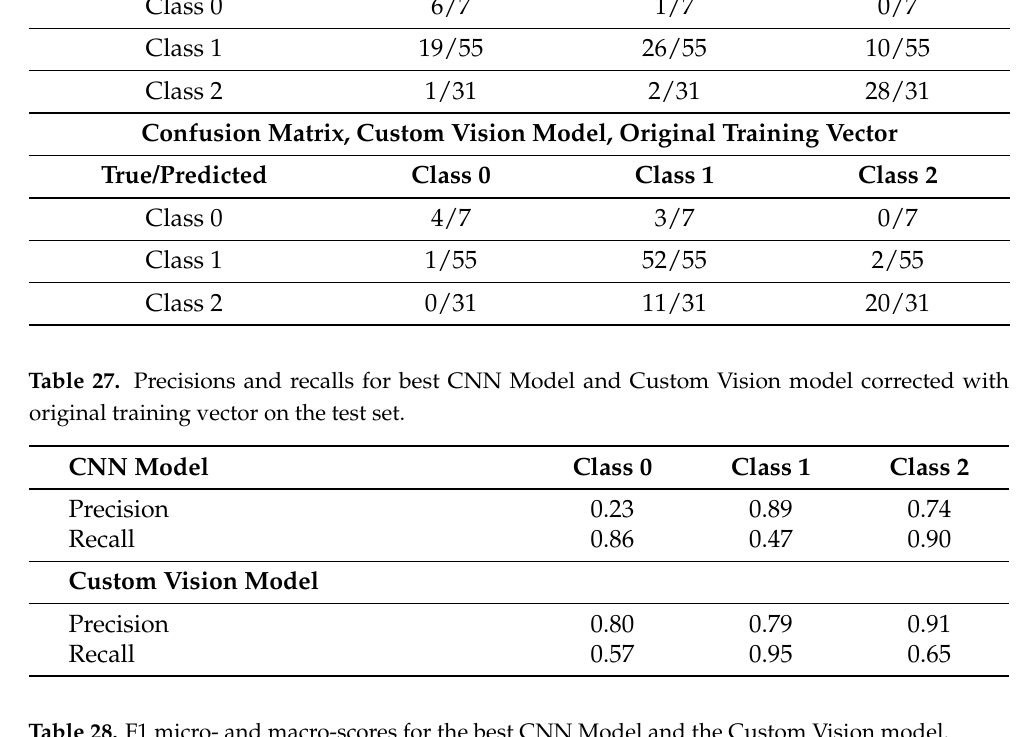
Table 28. F1 micro- and macro-scores for the best CNN Model and the Custom Vision